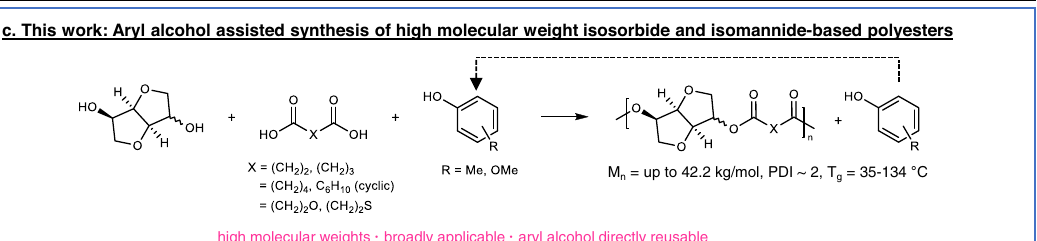
Fig.1|Previousliteratureandthiswork.a Comparisonofpreviousliteratureon the synthesis of poly(isosorbide succinate) (PIsSu) 9,11,12,29 – 35 . b Previous strate- gies to improve molecular weights of isosorbide-based polyesters 16,24,36 . c The synthesis strategy of this work. Not shown in b is a strategy reported by Kri- cheldorf et al. 37 . on the improvement of isosorbide-based polyester molecular